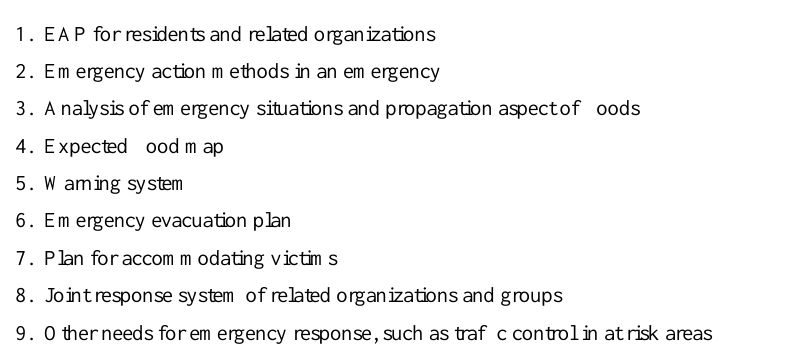
Table 1. Enforcement ordinance of countermeasures against natural disasters Act, Article